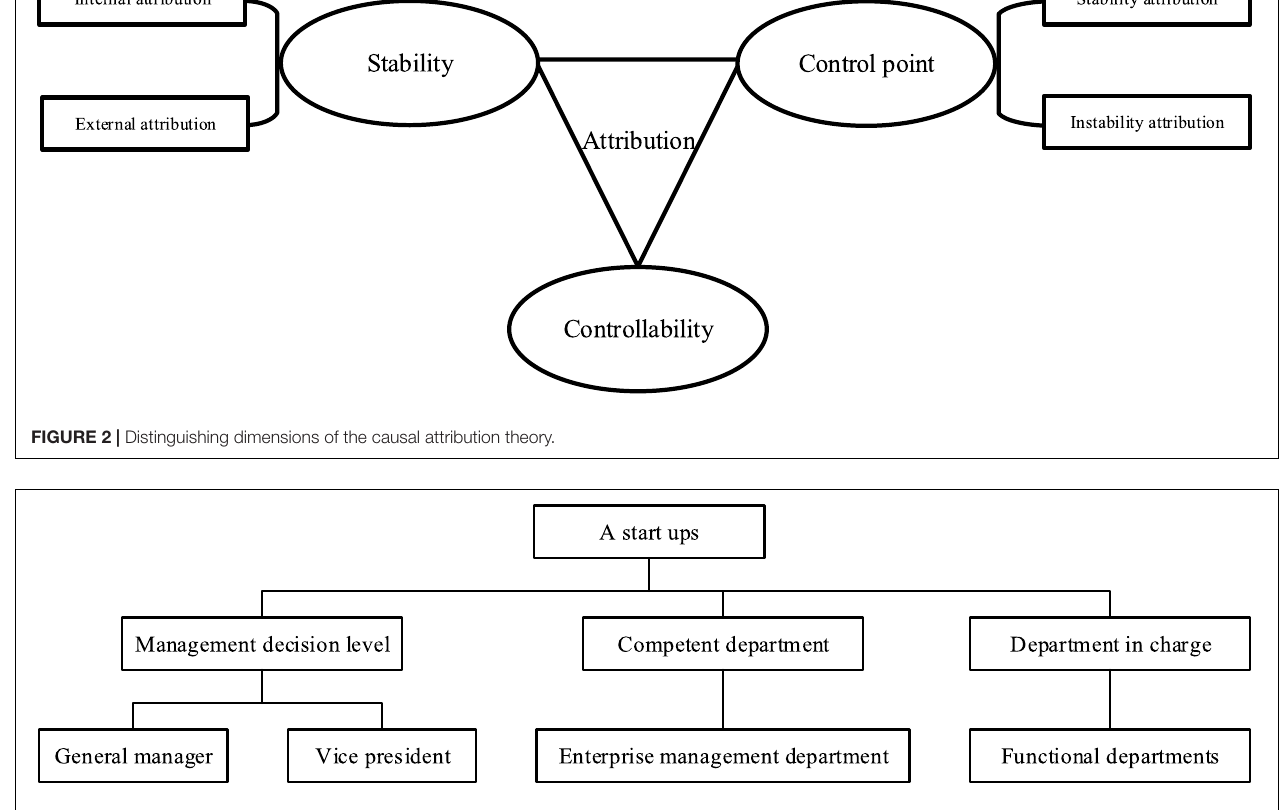
FIGURE 3 | Internal organization settings of new venture A.